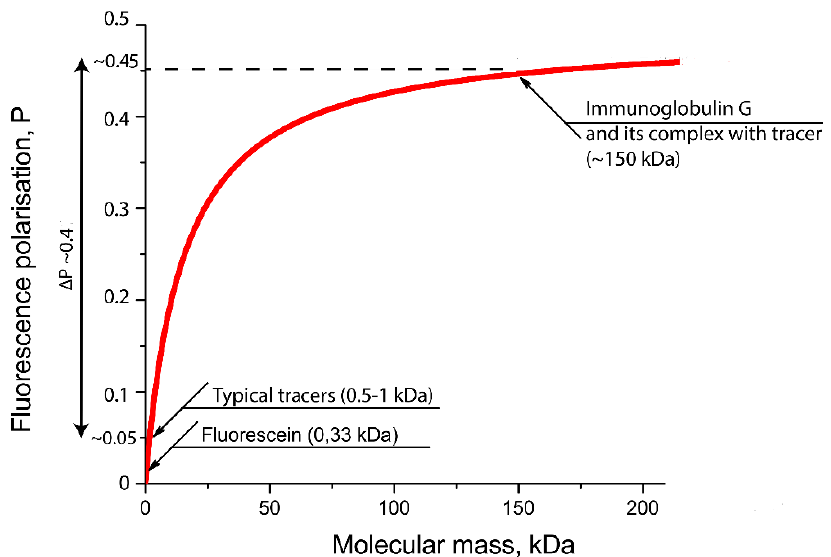
Figure 3. Dependence of the FP of the molecular weight of FITC-labeled preparations calculated on the basis of the Perrin equation (the formula and parameters for drawing are taken from [11]).